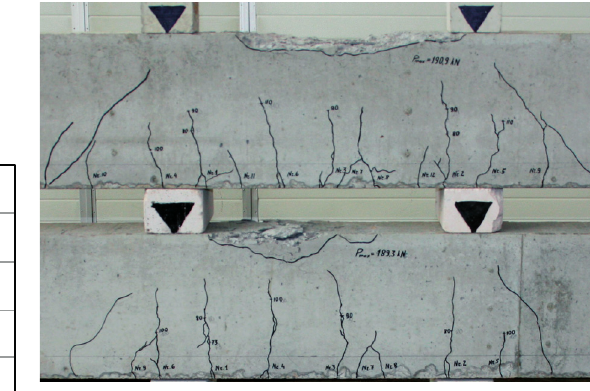
Fig. 7. Failure mode and distribution of cracks of prestressed beams SI-1 and